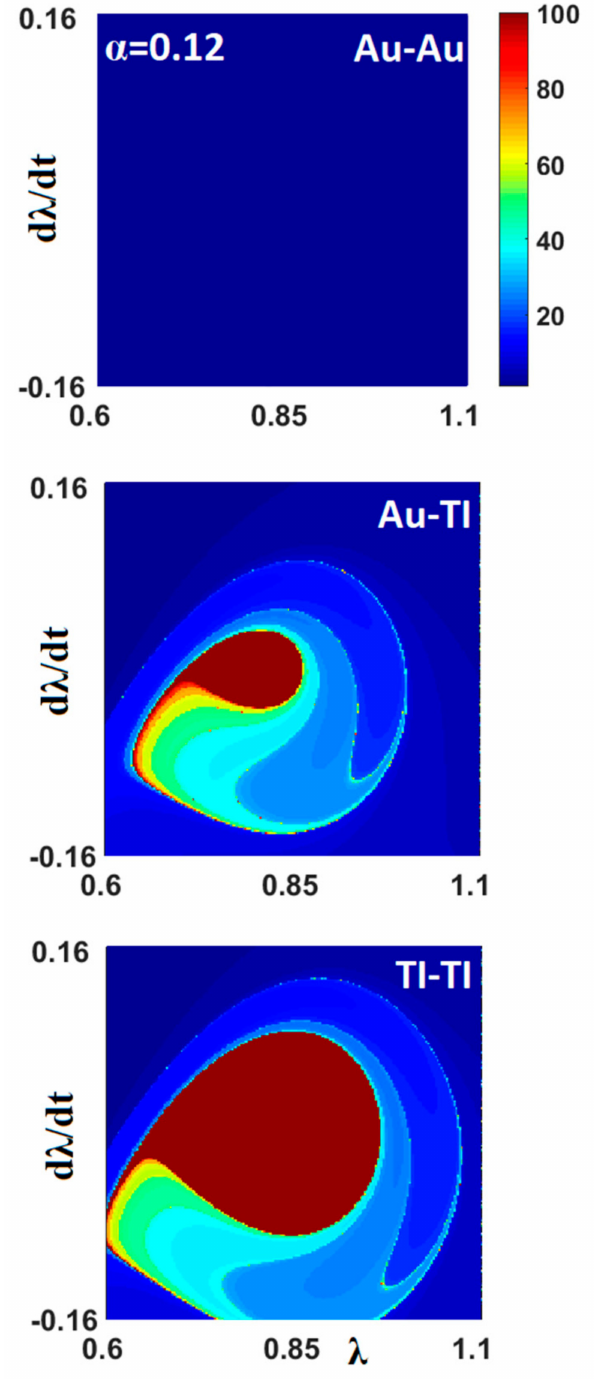
Figure 6. Contour plot of the transient times to stiction in the phase plane d λ /dt vs. λ for Scheme 250. nm, α = 0.12, ω / ω o = 0.5, and δ Cas = 0.065. For the calculations, we used 150 × 150 initial conditions ( λ , d λ /dt). The stable actuation (red) region increased significantly from Au-Au to TI-TI